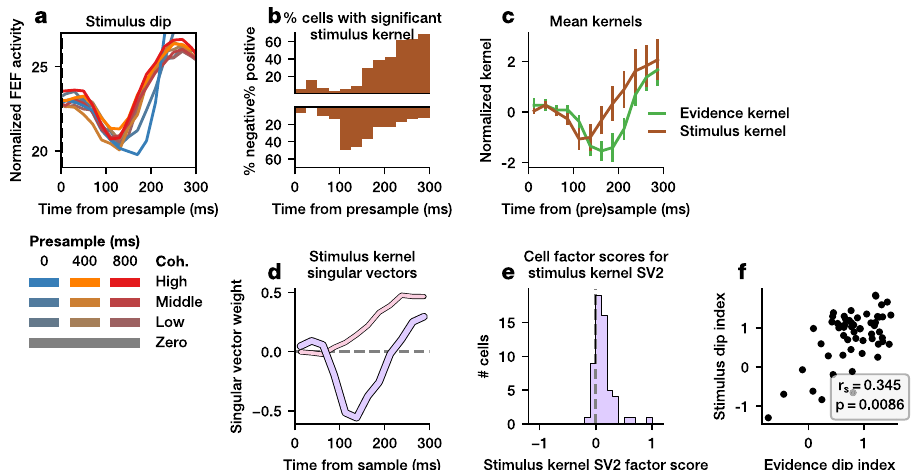
Fig. 5 Comparison of evidence and stimulus dips for Monkey 1. a Mean FEF activity is plotted for each presample and coherence condition at presample (400 or 800 ms presample) or sample (0 ms presample) onset. b The fraction of neurons at each point in time with signi fi cantly positive (top) or negative (bottom) stimulus kernel ( p < 0.05, one-tailed t test). c Mean stimulus kernel is shown with overlaid evidence kernel. Time is given as time since the sample (evidence kernel) or presample (stimulus kernel). Error bars indicate 95% con fi dence interval of the mean. d The fi rst (SV1) and second (SV2) singular vector of the stimulus kernels are shown, along with ( e ) the corresponding factor scores for each neuron on SV2. f Evidence dip index is plotted against stimulus dip index. Spearman correlation and two-tailed p-value is inset. Analyses are based on 57